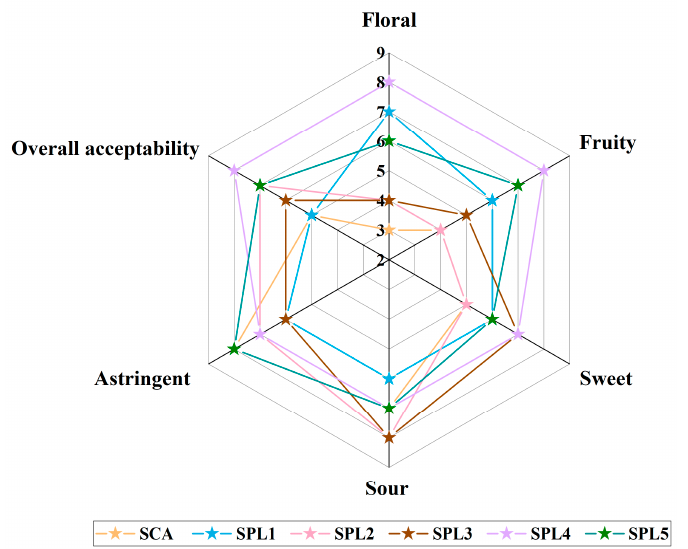
Figure 4. Sensory profiles obtained for ciders fermented with single-culture and triple mixed-cultures.